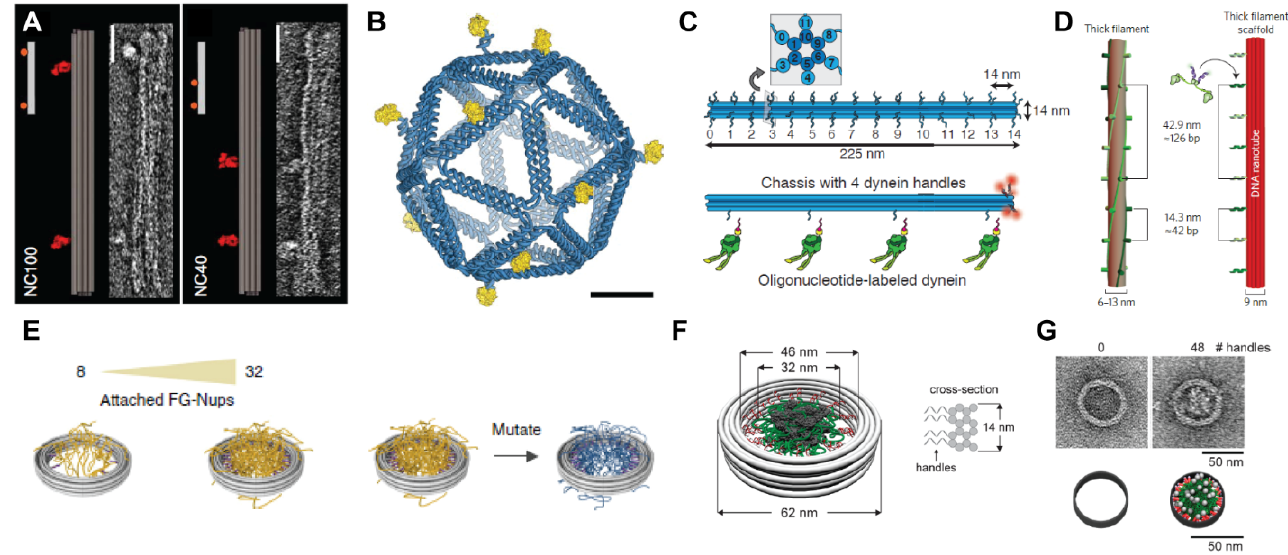
Figure 4. Controlling protein spacing, valence, and confinement with DNA objects. ( A ) DNA “nanocaliper” for spacing proteins at distances of 100 nm (left) and 40 nm (right). Reprinted with permission from ref. [26], Copyright 2014 Springer Nature. Insets show negative-stain TEM images of the calipers. ( B ) Icosahedral DNA cage for presenting the eOD-GT8 antigen (in yellow) to create synthetic vaccines. Reprinted with permission from ref. [27], Copyright 2020 Springer Nature. ( C , D ) DNA origami templates for controlling the spacing and stoichiometry of molecular motors like dynein. Reprinted with permission from ref. [37], Copyright 2012 The American Association for the Advancement of Science. ( C ) or myosin Reprinted with permission from ref. [38], Copyright 2015 Springer Nature. ( D ). ( E , F ) DNA origami rings for attaching FG-Nup proteins to mimic the nuclear pore complex. Reprinted with permission from ref. [29], Copyright 2018 Springer Nature. Reprinted with permission from ref. [28], Copyright 2018 American Chemical Society. ( G ) Negative stain TEM images (top) and cartoons (bottom) of rings with zero or 48 handles for FG-Nup proteins. Reprinted with permission from ref. [28], Copyright 2018 American Chemical Society.